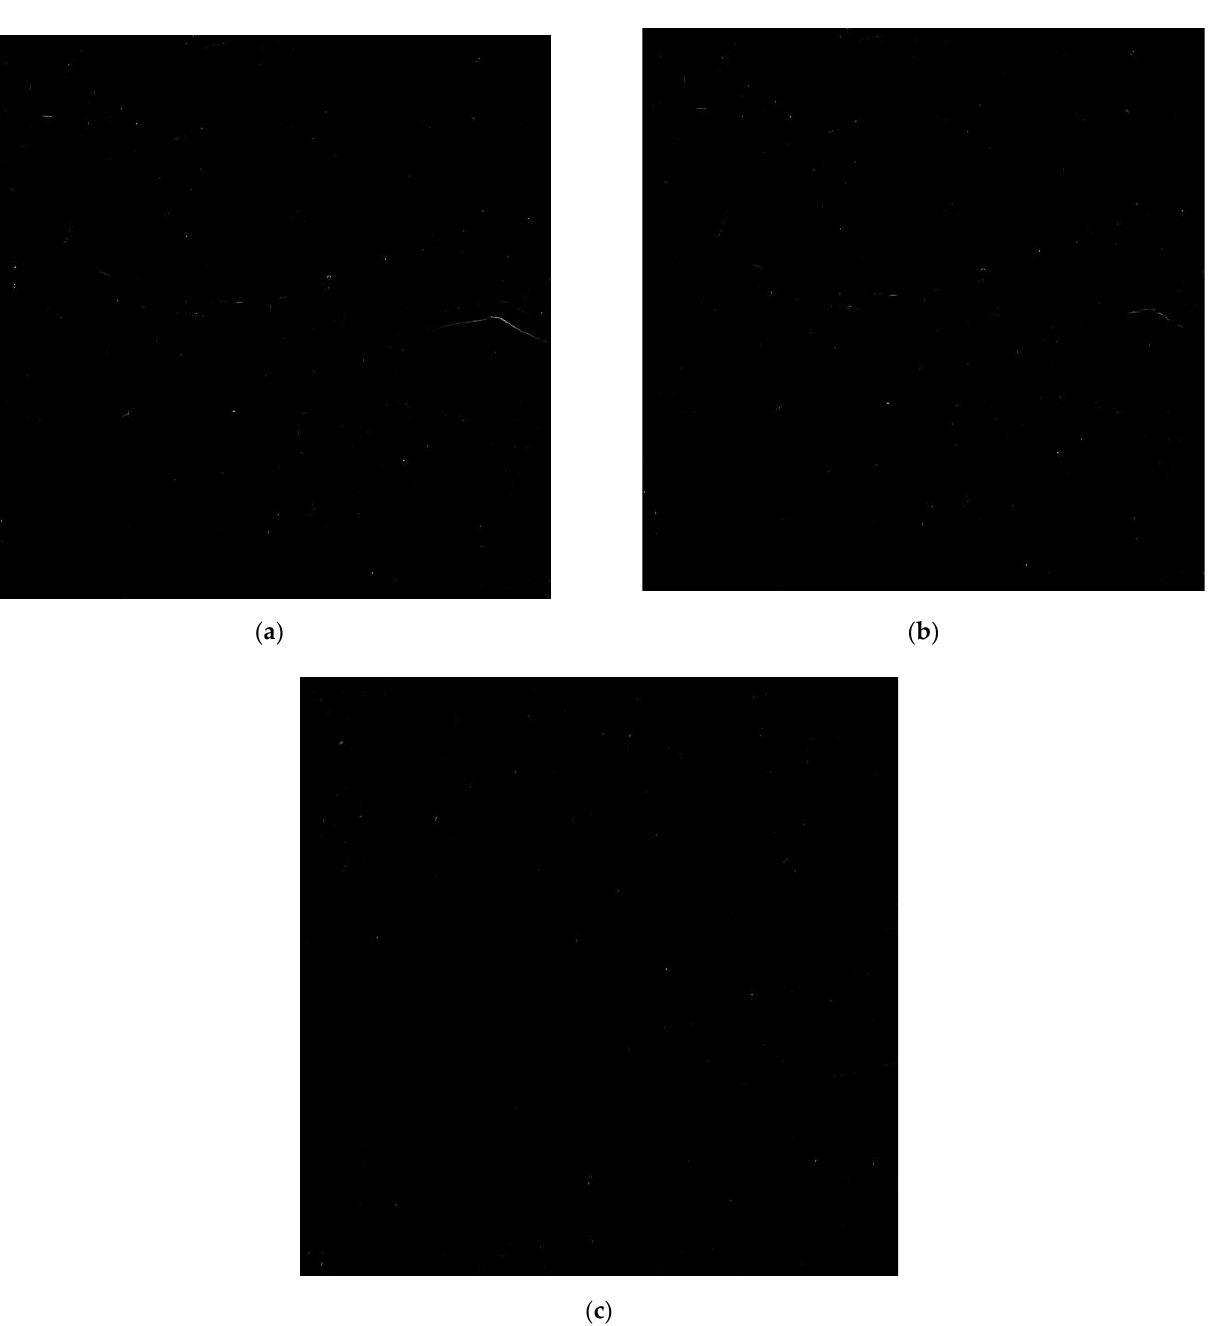
Figure 15. Surface dark field test results under the uniform scanning removal based on the magnetorheological rotation angle. ( a ) Surface Dark Field Test Results under the Uniform Scanning Removal of 20 nm Based on the Magnetorheological Rotation Angle; ( b ) Surface Dark Field Test Results under the Uniform Scanning Removal of 50 nm Based on the Magnetorheological Rotation Angle; ( c ) Surface Dark Field Test Results under the Uniform Scanning Removal of 100 nm Based on the Magnetorheological Rotation Angle.